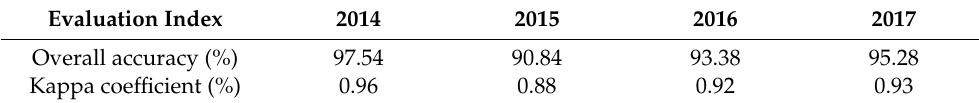
Figure 6. Statistics of habitat area from 2014 to 2017 in HDSL.